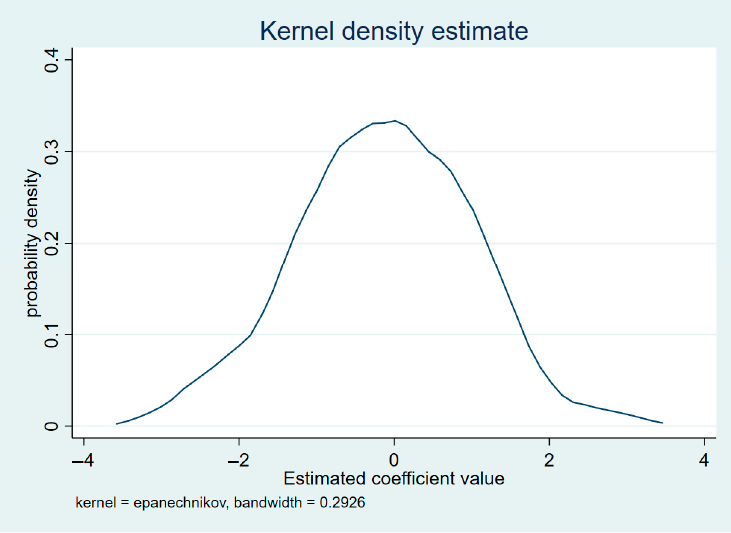
Figure 3. Coefficient distribution of 200 results.